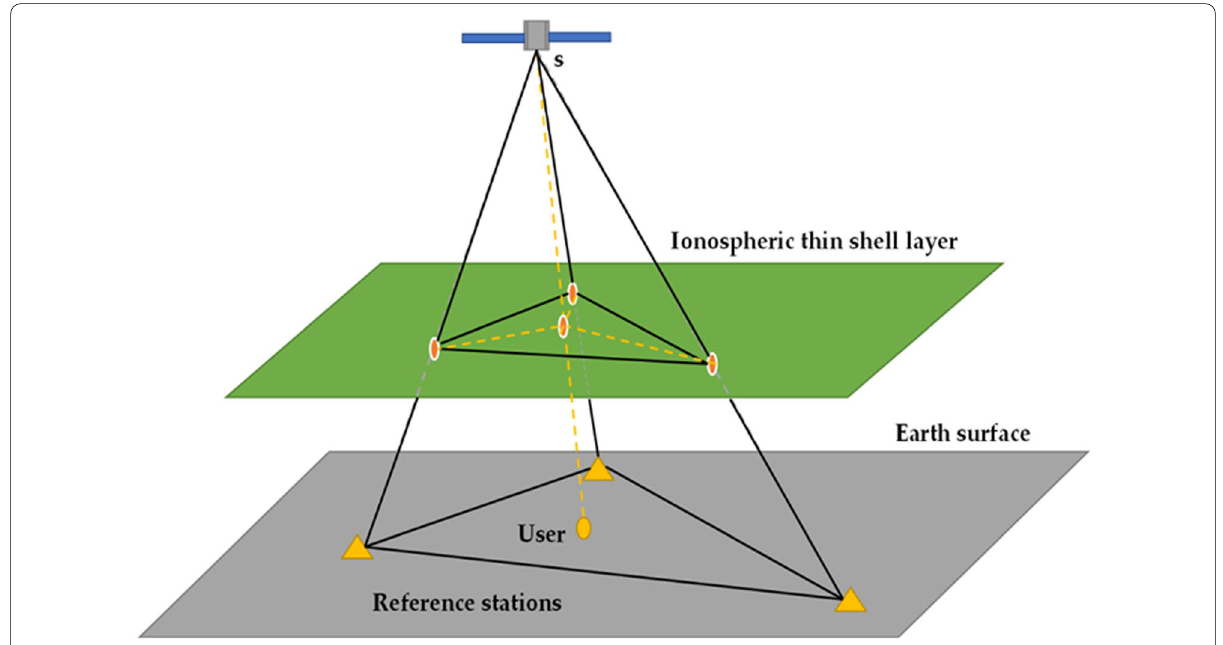
Fig. 2 DIM interpolation